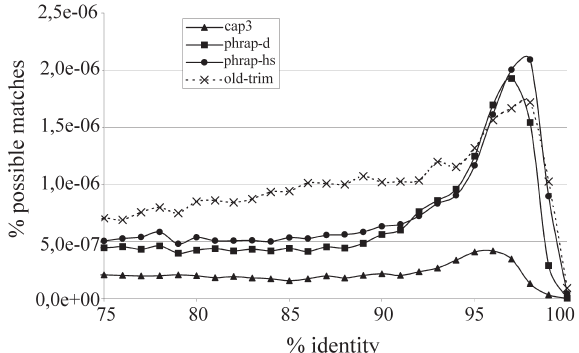
Figure 5 - Plot of external consistency test results. For a given assembly with n clusters the number of overlaps detected was divided by n(n-1)/2, which is the maximum number of possible overlaps for n